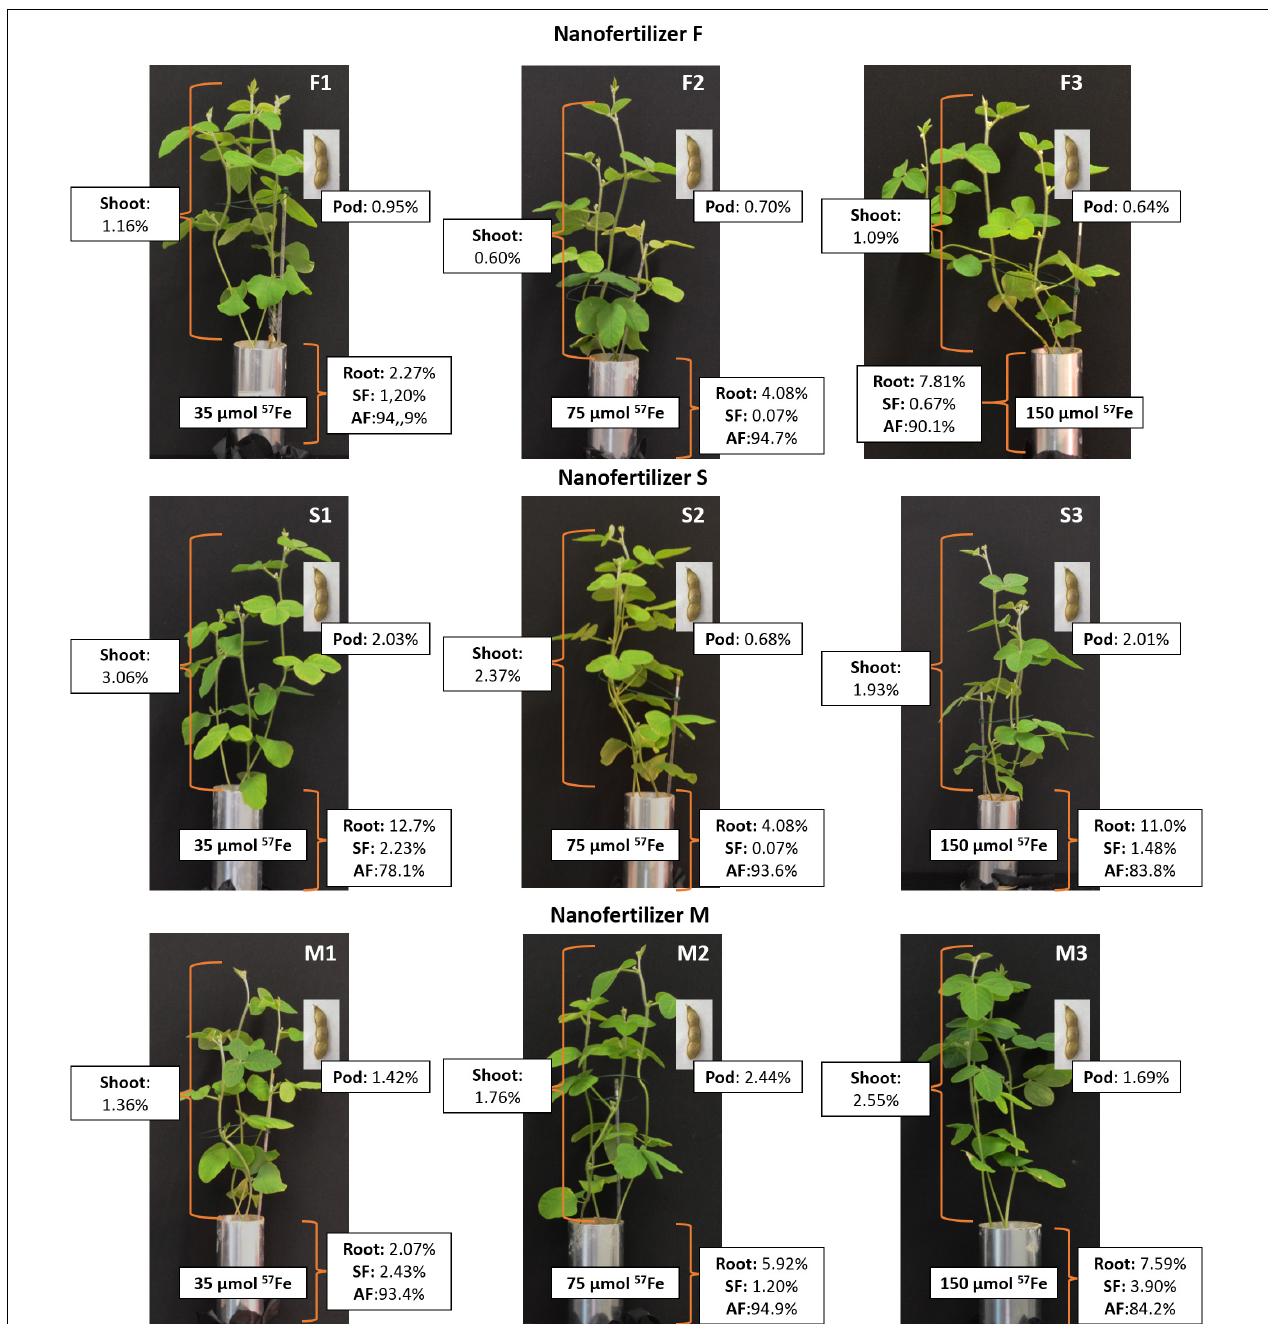
FIGURE 10 | Distribution of 57 Fe (%) in soybean shoots, pods and roots of plants fertilized with the 57 Fe products F, S, and M in three doses: (1) 35, (2) 75, and (3) 150 µ mol 57 Fe pot − 1 and in the soluble and available fraction